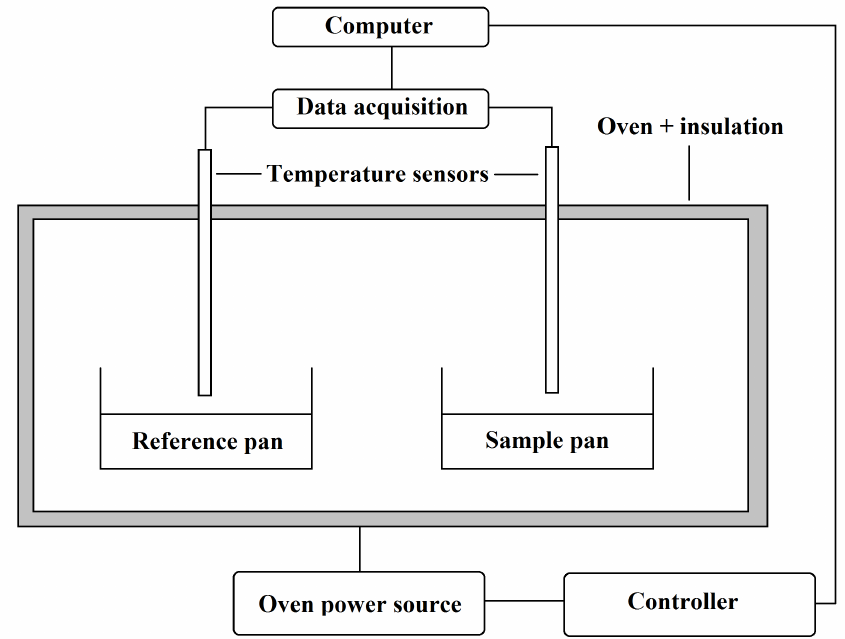
Figure 3. Simplified schematic depiction of a differential thermal analyser, based on [15,16] and a variety of schemes provided by DTA equipment manufacturers. Modern DTA instruments largely utilise reference and sample vessels placed in contact with thermocouples rather than allowing sample–thermocouple